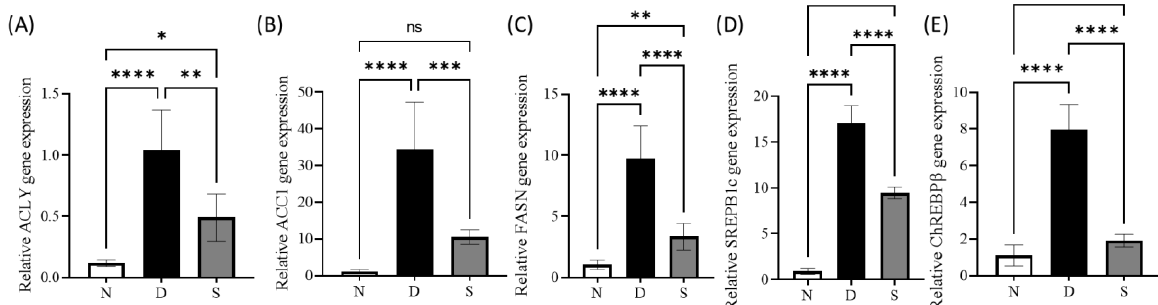
Figure 3. Effect of Swietenine on key enzymes involved in de novo lipogenesis ( A ) ACLY, ( B ) ACC1 and ( C ) FASN, and two transcriptional lipogenesis regulatory genes (( D ) SREPB1c and ( E ) ChREBP β ). It is observed that these genes are significantly upregulated in diabetic mice, but the effect was significantly reversed in the treatment group with swietenine (80 mg/kg). The treatment with swietenine resulted in a non-significant ACCA and ChREBP β difference in the levels compared to their respective normal group. N, normal group; D, diabetic mice group; S, treatment with swietenine (80 mg/kg) group. ns: Not significant; * p < 0.05, ** p < 0.01, *** p < 0.001, **** p < 0.0001.